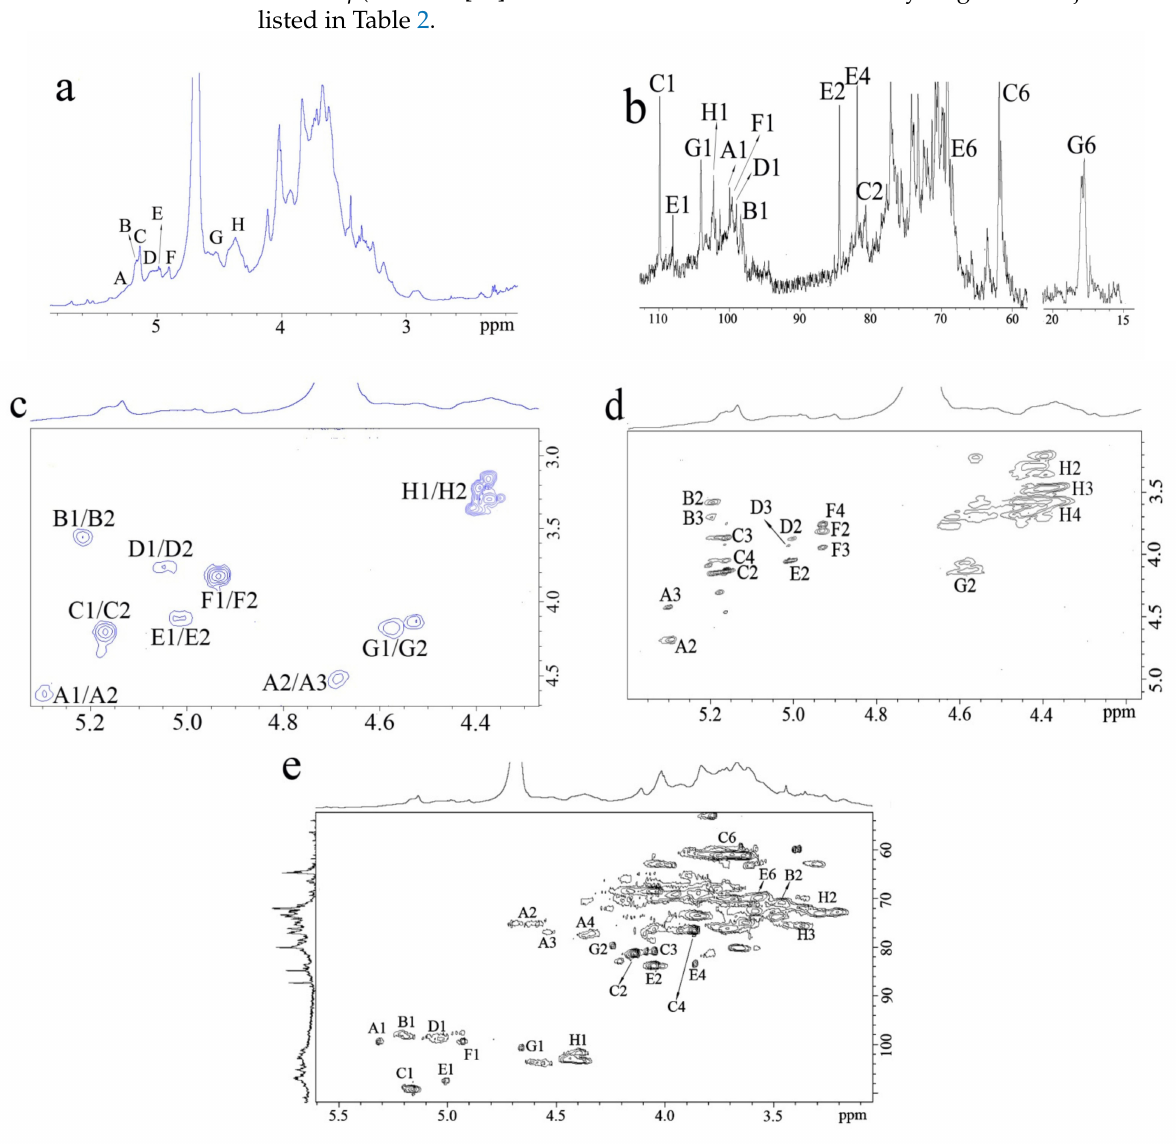
Figure 3. NMR spectra of F2-1. ( a ) 1 H NMR spectrum; ( b ) 13 C NMR spectrum; ( c ) part of 1 H– 1 H COSY spectrum; ( d ) part of 1 H– 1 H TOCSY spectrum; ( e ) 1 H– 13 C HSQC